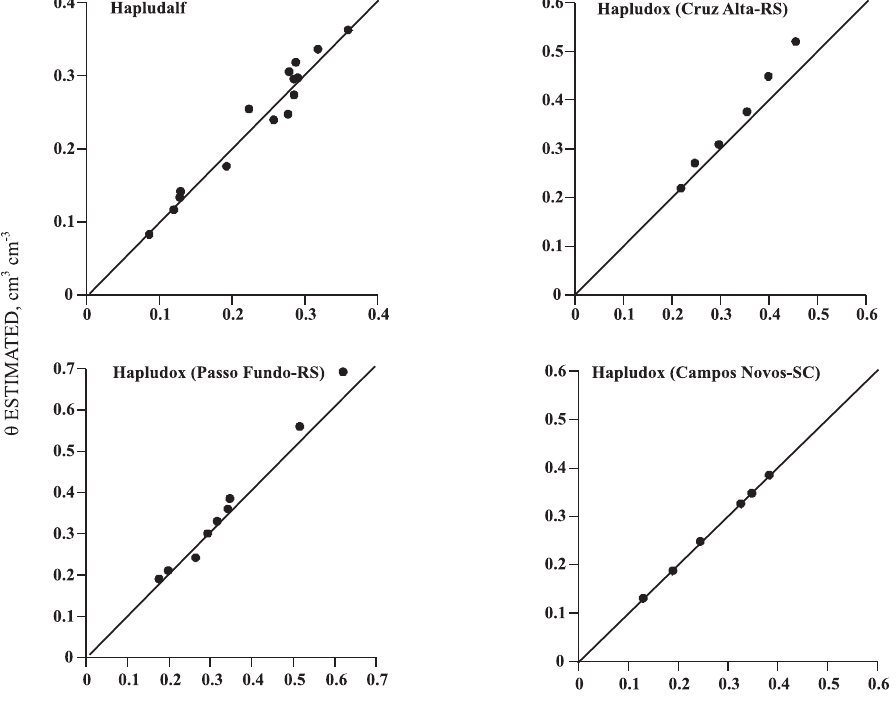
Figure 8. Relationship (1:1 graphic) between the volumetric soil moisture observed and that estimated with the polynomial